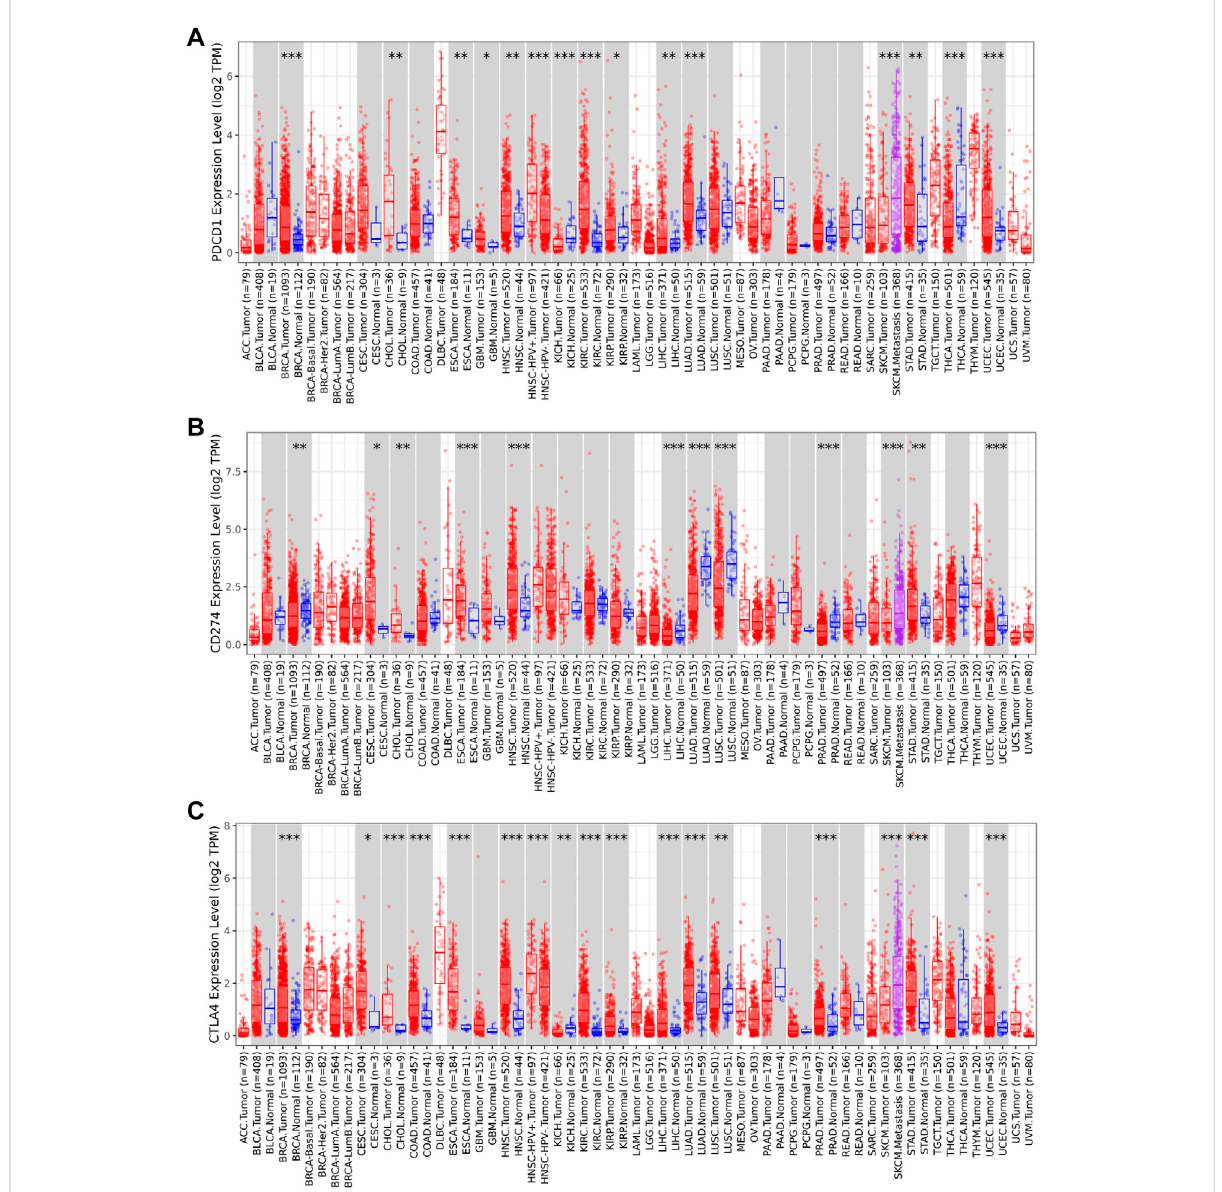
FIGURE 4 Expression level of PD-1, PD-L1, CTLA-4 genes in different tumors and pathological stages. The expression levels of PD-1 (A) , PD-L1 (B) and CTLA-4 (C) genes in pan-cancer or speci fi c cancer subtypes and paired non-tumor samples from TCGA database was analyzed through TIMER2 . (A,B,C) PD-1, PD-L1, CTLA-4 showed up-regulation in CHOL (Cholangiocarcinoma), ESCA (Esophageal carcinoma), HNSC (Head and Neck squamous cell carcinoma), and SKCM-Metastasis (Skin Cutaneous Melanoma-Metastasis), STAD (Stomach adenocarcinoma). PD-1 (A) and CTLA-4 (C) are up-regulated in BRCA (Breast invasive carcinoma), LIHC (Liver hepatocellular carcinoma), LUAD (Lung adenocarcinoma), UCEC (Uterine Corpus Endometrial Carcinoma), while PD-L1 (B) is signi fi cantly down-regulated in BRCA, LIHC, LUAD, and UCEC (* p < 0.05; ** p < 0.01; *** p <